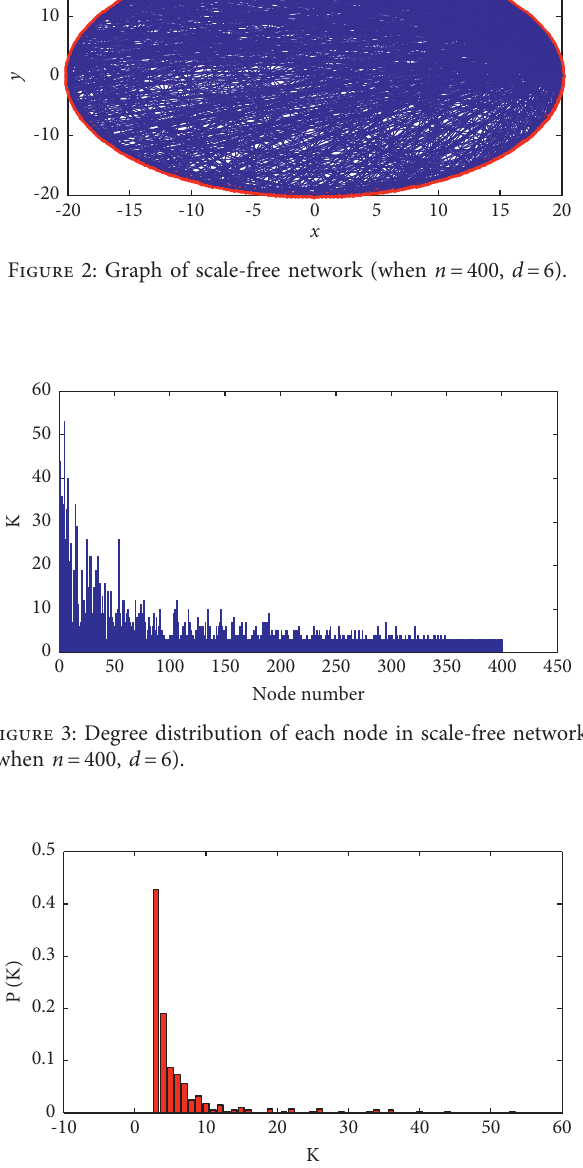
Figure 4: Probability distribution of degree of each node in scale- free network (when n � 400, d � 6).